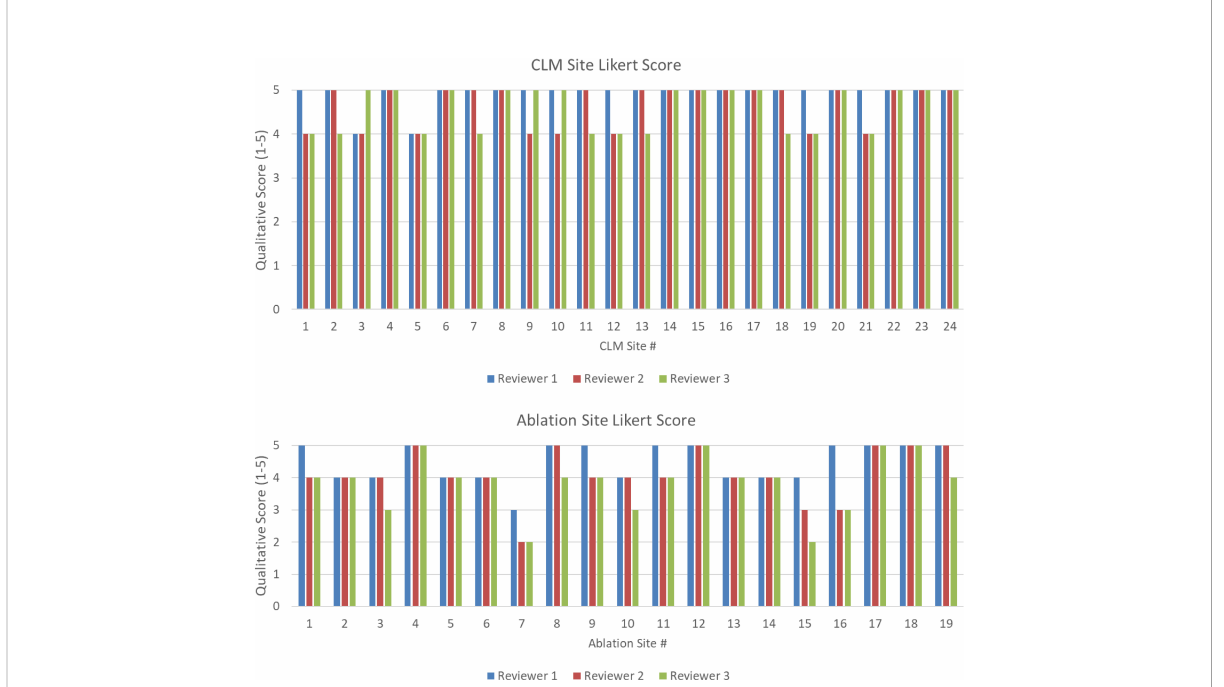
FIGURE 6 (Top) Likert score by each reviewer for each disease site. (Bottom) Likert score by each reviewer for each ablation site. A higher value is associated with higher